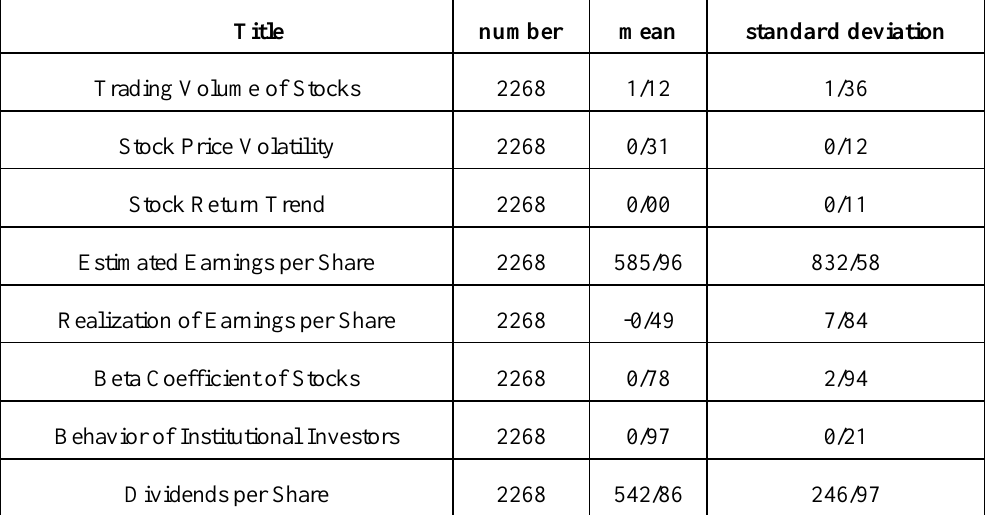
Table 1. Descriptive Statistics of the Data Collected for the Independent Variables